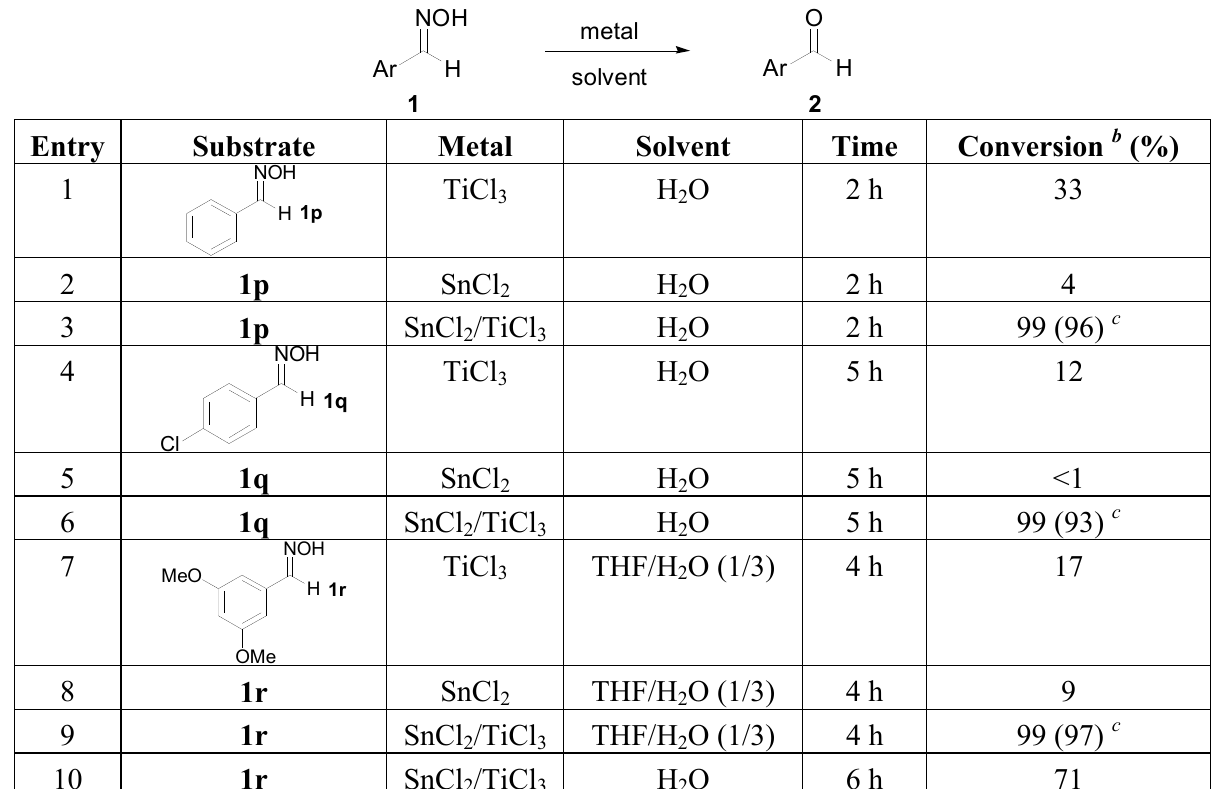
Table 3. Metal halide-mediated deoximation of aldoxime a